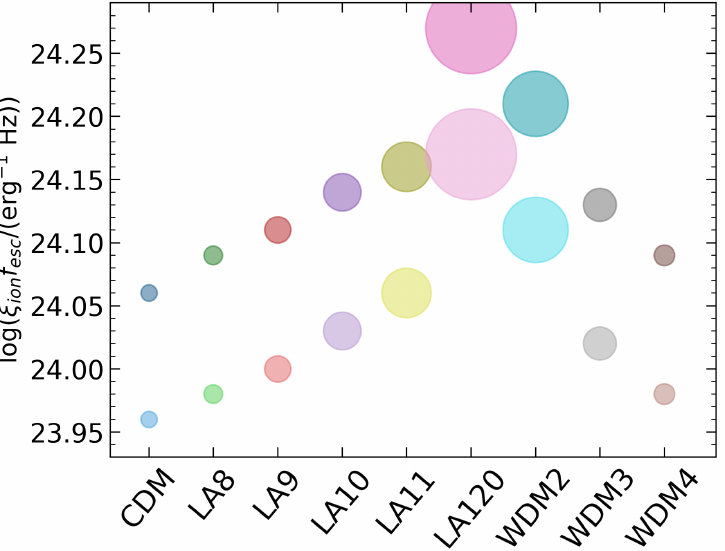
Figure 5. The panel shows the values of the product ξ ion f esc required to ionize the IGM at z = 6.7, for a set of different cosmologies. The dot size increases with M hm ; lighter colours refer to initial condition Q HII ( z = 10 ) = 0.2, while darker colours are for Q HII ( z = 9 ) =